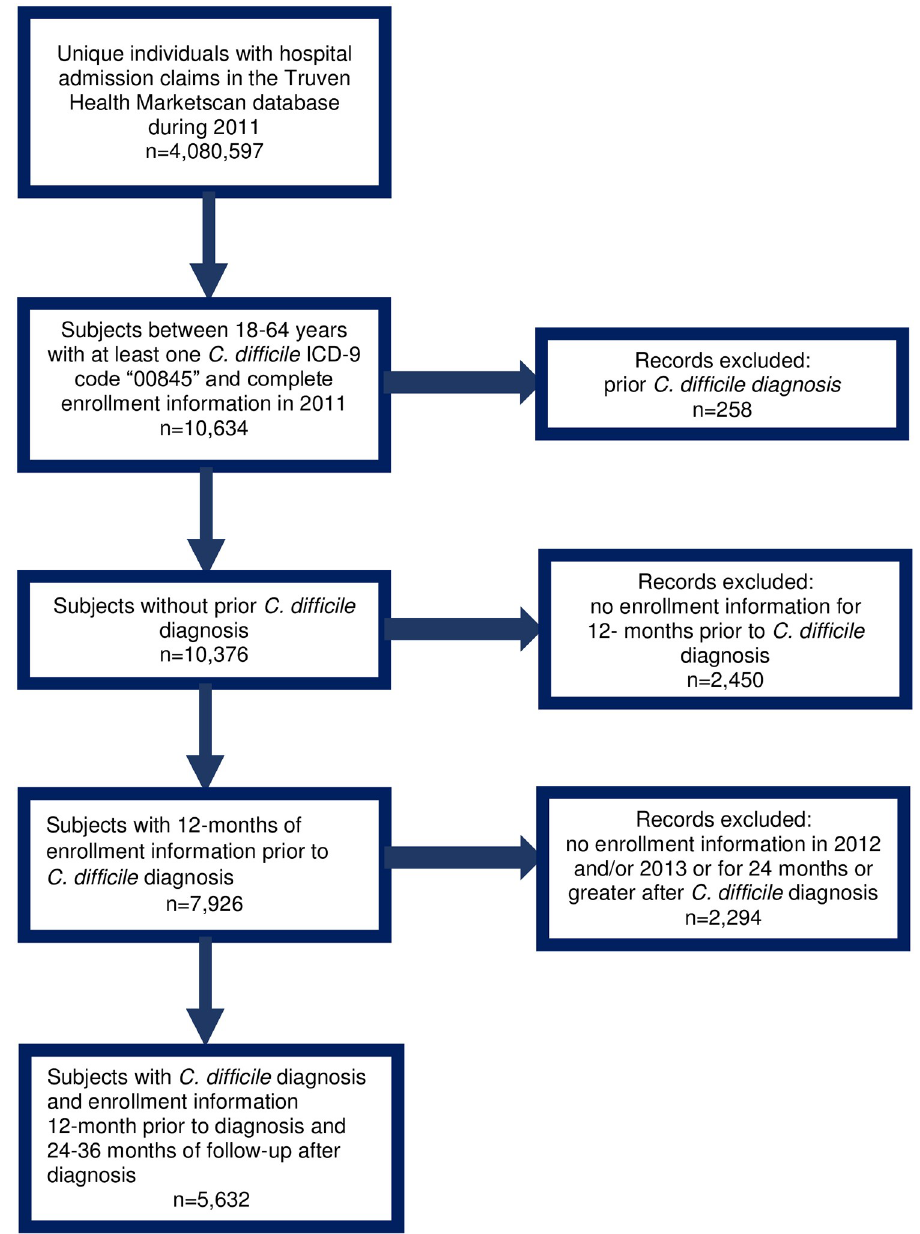
Fig 1. Selection criteria